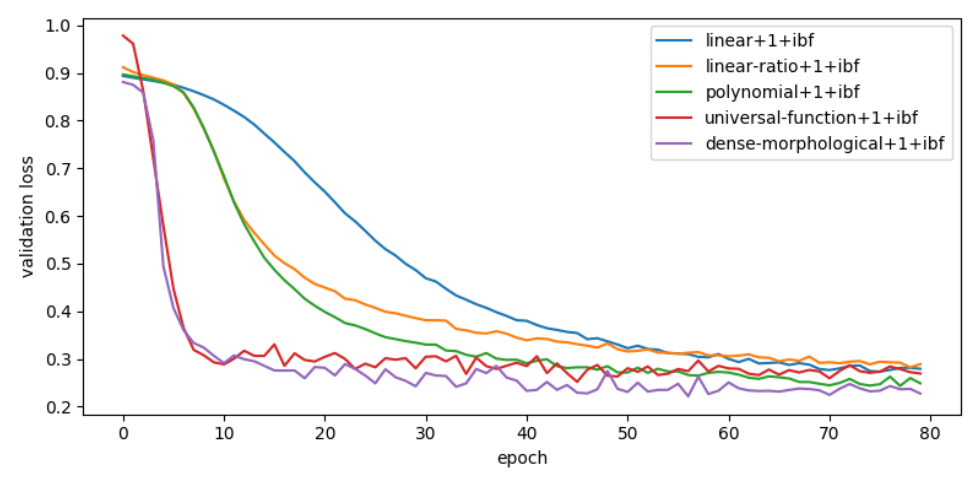
Figure 12. first 80 epochs of loss of generic models with ibf in kernel size of 1.